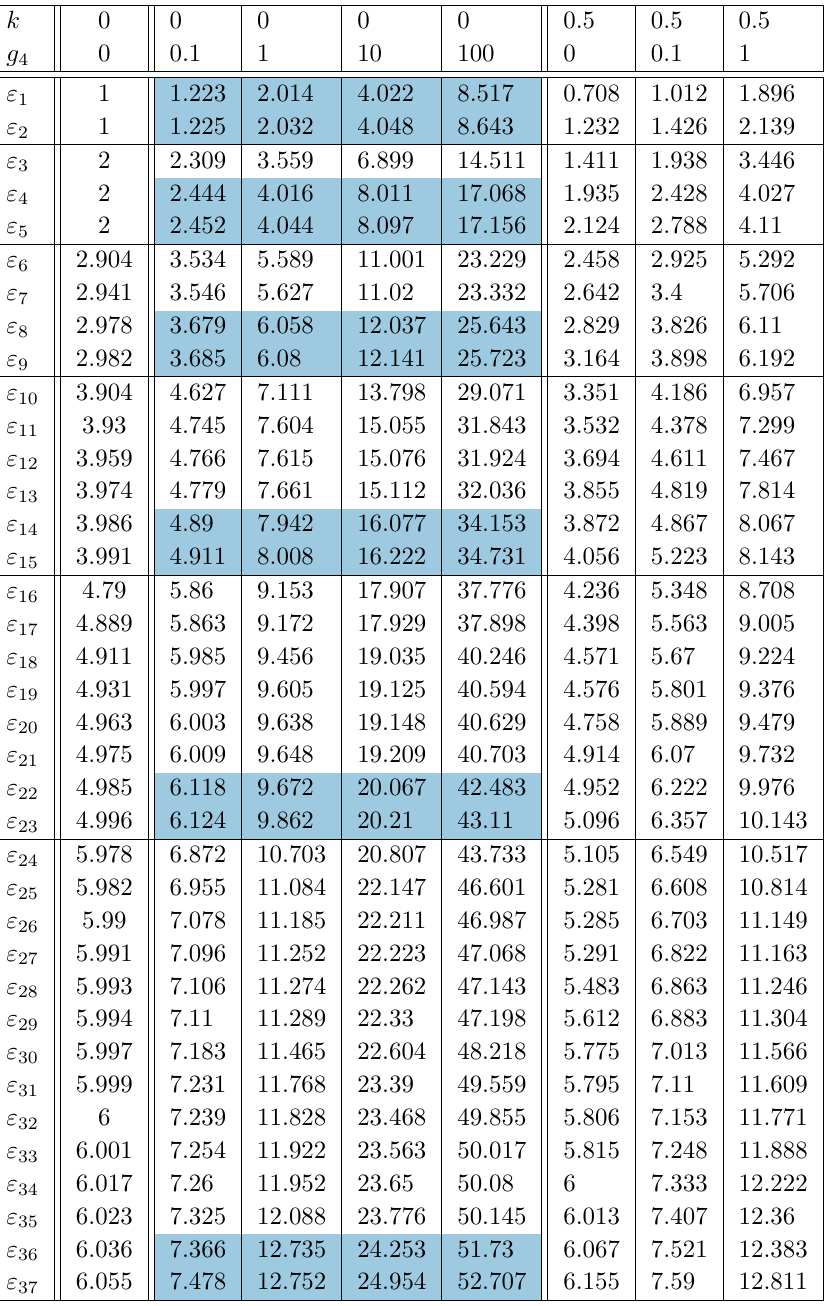
Table 16. Two-matrix spectrum with loop length truncation l = 7